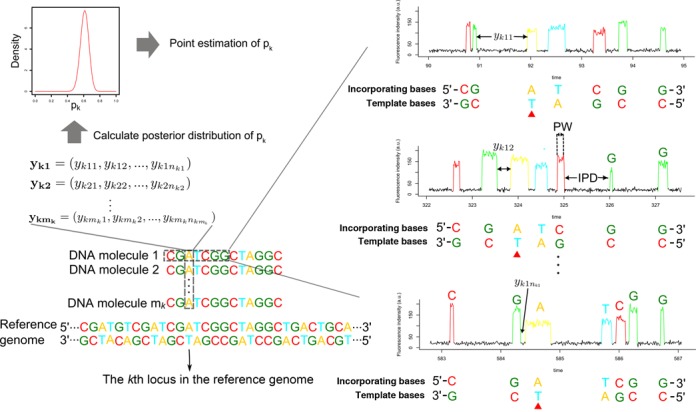
Quantitative detection of DNA modification heterogeneity. There are mk bases covering the kth locus, and they are sequenced nk1, nk2, ... and \documentclass[12pt]{minimal}
\usepackage{amsmath}
\usepackage{wasysym}
\usepackage{amsfonts}
\usepackage{amssymb}
\usepackage{amsbsy}
\usepackage{upgreek}
\usepackage{mathrsfs}
\setlength{\oddsidemargin}{-69pt}
\begin{document}
}{}$n_{k{m_k}}$\end{document} times, respectively. The ‘T’ at the kth locus in the reference genome has an IPD vector, denoted by \documentclass[12pt]{minimal}
\usepackage{amsmath}
\usepackage{wasysym}
\usepackage{amsfonts}
\usepackage{amssymb}
\usepackage{amsbsy}
\usepackage{upgreek}
\usepackage{mathrsfs}
\setlength{\oddsidemargin}{-69pt}
\begin{document}
}{}$\mathbf {{\it y}_{{\it k}1}}$\end{document}, \documentclass[12pt]{minimal}
\usepackage{amsmath}
\usepackage{wasysym}
\usepackage{amsfonts}
\usepackage{amssymb}
\usepackage{amsbsy}
\usepackage{upgreek}
\usepackage{mathrsfs}
\setlength{\oddsidemargin}{-69pt}
\begin{document}
}{}$\mathbf {{\it y}_{{\it k}2}}$\end{document},..., \documentclass[12pt]{minimal}
\usepackage{amsmath}
\usepackage{wasysym}
\usepackage{amsfonts}
\usepackage{amssymb}
\usepackage{amsbsy}
\usepackage{upgreek}
\usepackage{mathrsfs}
\setlength{\oddsidemargin}{-69pt}
\begin{document}
}{}$\mathbf {{\it y}_{\it km_k}}$\end{document}. Given the IPD vector, the posterior distribution of proportion of kinetic variant bases covering the kth locus, pk, can be estimated by qDNAmod. A point estimation of pk can be inferred from its posterior distribution.